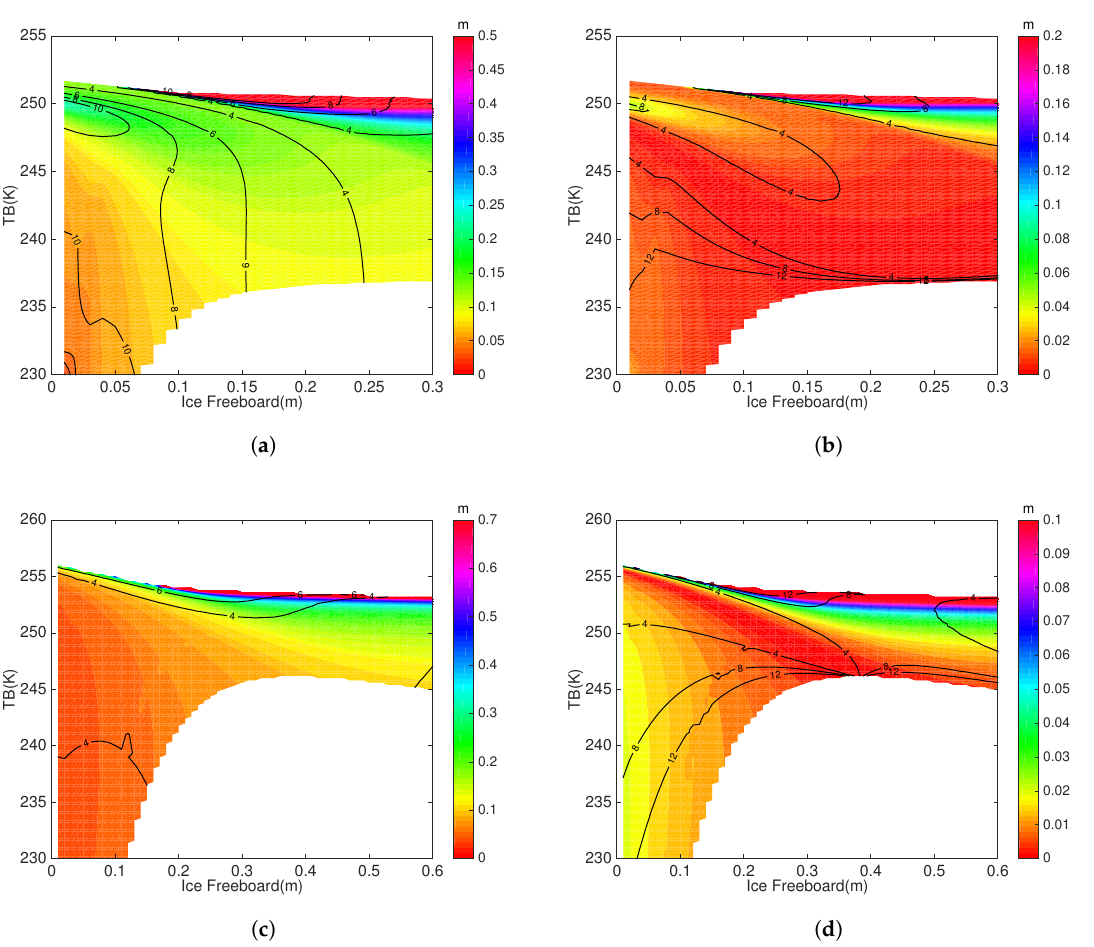
Figure 7. Sensitivity study of retrieved parameters to freeboard measurements. Results for the synergy between TB and FB ice are shown. ( a , b ) show the sensitivity of the retrieved hi and hs to FB ice for FYI, respectively. ( c , d ) show the results for MYI. The filled color contour is the absolute uncertainty of hi or hs (in meters ), and the labeled lines are the relative uncertainty (units: %). The uncertainty for FB ice is quantified in terms of standard deviations according to Table 3. The absolute uncertainty in hi or hs (denoted (cid:101) absolute ) is the quantitative difference in hi or hs as caused by perturbation to FB ice or TB by 1 standard deviation. The relative uncertainty of y is computed as: (cid:101) relative y is the corresponding value of hi or hs